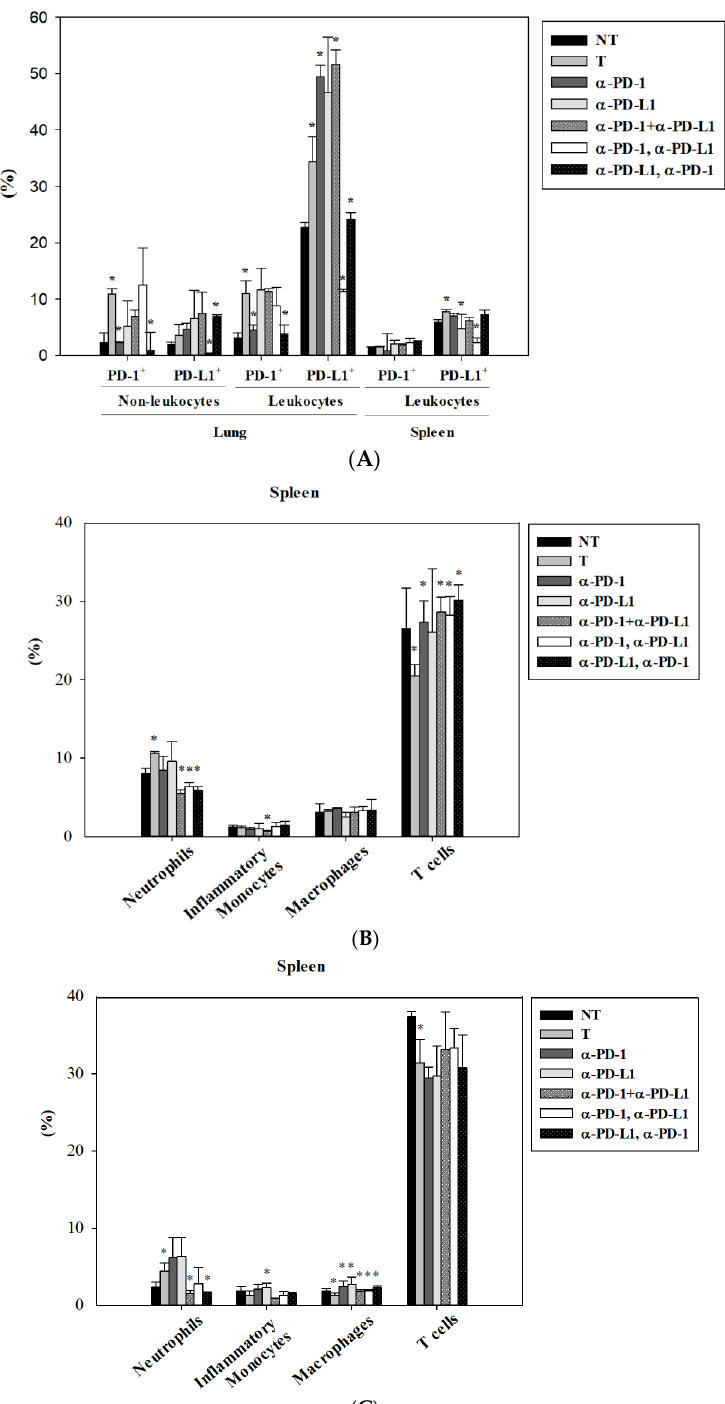
Figure 4. Alterations of circulating immune cells in a lung metastatic animal model after monotherapy and various combination treatments of anti-PD-1 and anti-PD-L1. ( A ) Flow cytometric analysis for expression of PD-1 and PD-L1 on leukocytes (CD45 + ) and non-leukocytes (CD45 − ) in the lung and spleen on day 11 post-treatment. ( B ) Immune cell composition in the spleen on day 11 post-treatment in lung metastasis mice. ( C ) Immune cell composition in the spleen on day 17 post-treatment in lung metastasis mice. The tumor (T) group from lung metastatic mice was compared with the no tumor (NT) group from normal mice. In ICI-treated groups, statistical analysis was performed with the tumor (T) group (* p < 0.05). Total leukocytes (CD45 + ) = 100%. Immune cells were defined as follows: neutrophils (CD11b + / Ly6G + ), inflammatory monocytes (CD11b + / Ly6C ++ ), macrophages (CD3 − / CD11b + / Ly6C + / F4 / 80 + ), T cells (CD3 + / CD11b − ). n = 3 for each